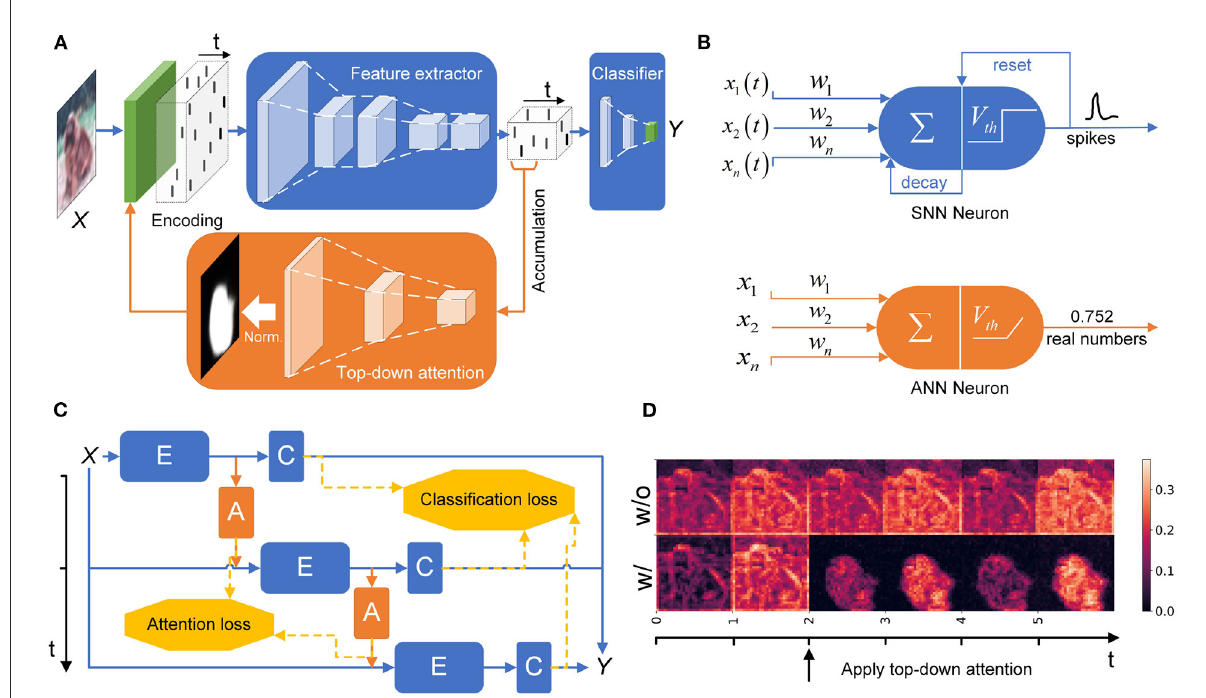
FIGURE1 (A) The schematic of the HTDA model. The SNN-based feature extractor generates a spatiotemporal representation, which is then fed into an ANN to generate top-down attention maps and a classifier to give predictions. The attention map modulates the encoding layer of the SNN. (B) Neuronal models used in the HTDA model. (C) Training methods of the HTDA model. The HTDA model is jointly trained by unrolling in the time dimension. A weakly-supervised objective is designed to optimize the attention map generator. (D) Firing rates of the encoding layer of the feature extractor with or without top-down attention. The firing rate is calculated as the proportion of firing neurons in different channels at a certain spatial location at a certain time step.